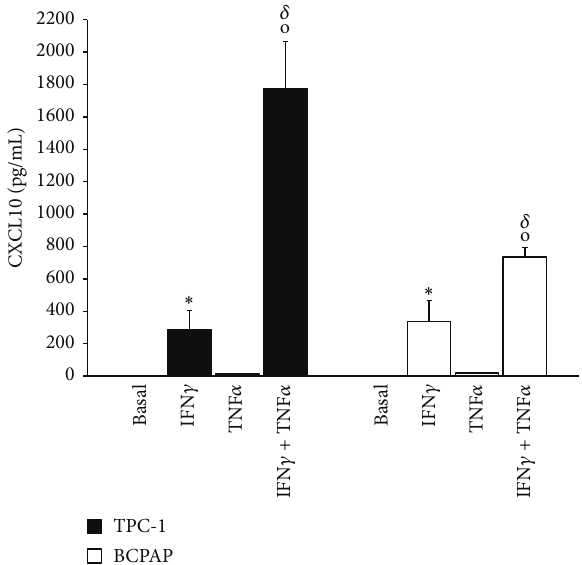
Figure 3: CXCL10 secretion in TPC-1 and BCPAP cells in basal con- dition, after treatment with IFN 𝛾 1000U/mL and TNF 𝛼 10ng/mL alone or in combination. ∗ 𝑝 < 0.05 versus basal; ∘ 𝑝 < 0.05 versus IFN- 𝛾 ; 𝛿 𝑝 < 0.05 TPC-1 versus